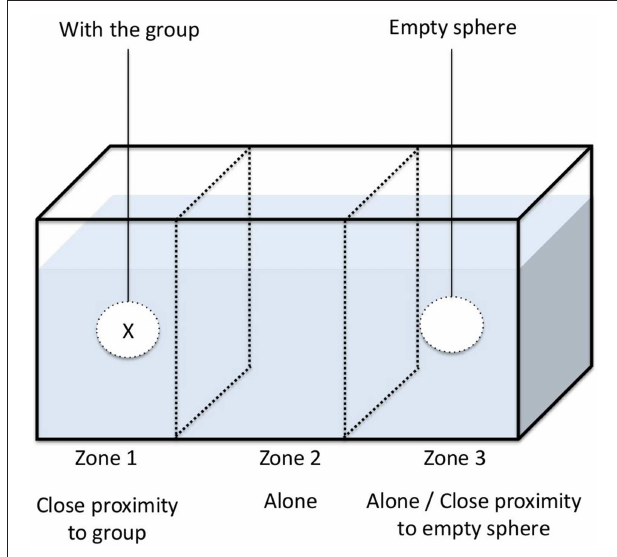
FIGURE 1 | Experimental set